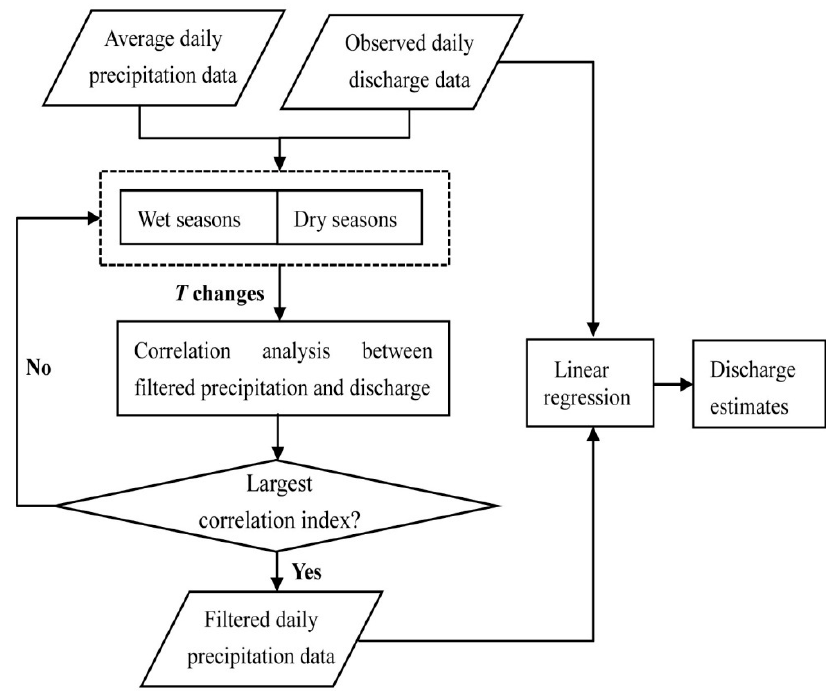
Figure 3. Flow chart of filtering and linear regression (FLR), where T is a time parameter in the exponentially smoothing filter model.